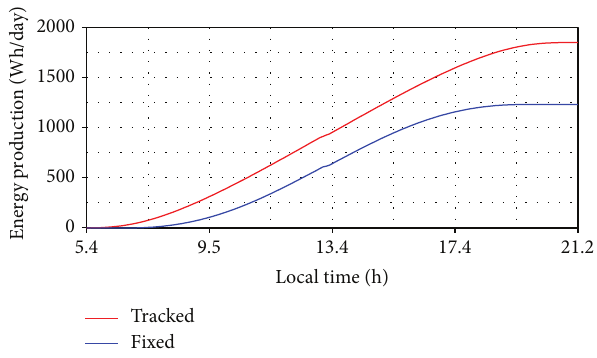
Figure 13: The energy production (with and without tracking).